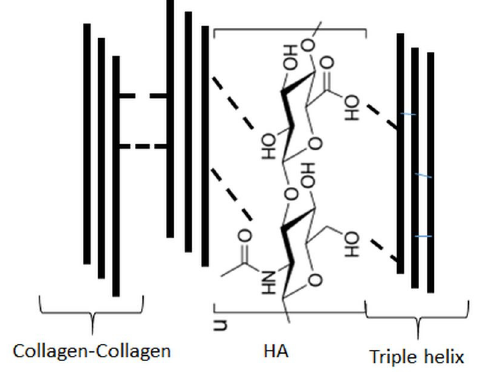
Figure 2. Possible interactions between collagen and hyaluronic acid (HA) in blends.